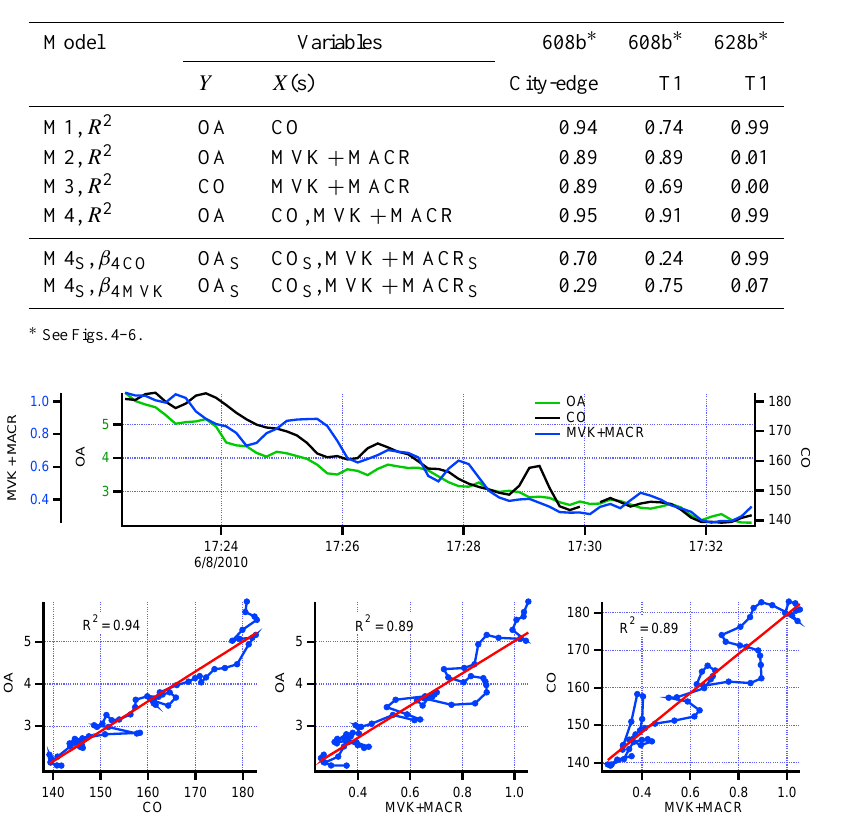
Figure 4. Flight 608b City-Edge transect. Top graph: time series of OA, CO, and MVK + MACR. OA in µgm − 3 ; CO and MVK + MACR in ppbv. Time is Pacific Standard Time. Bottom plots: correspond from left to right to models M1, M2, and M3 listwise deletion used for correlations but not used for graphs. Data points on scatter plots connected to give a sense of time continuity. Red lines are least-squares fit to